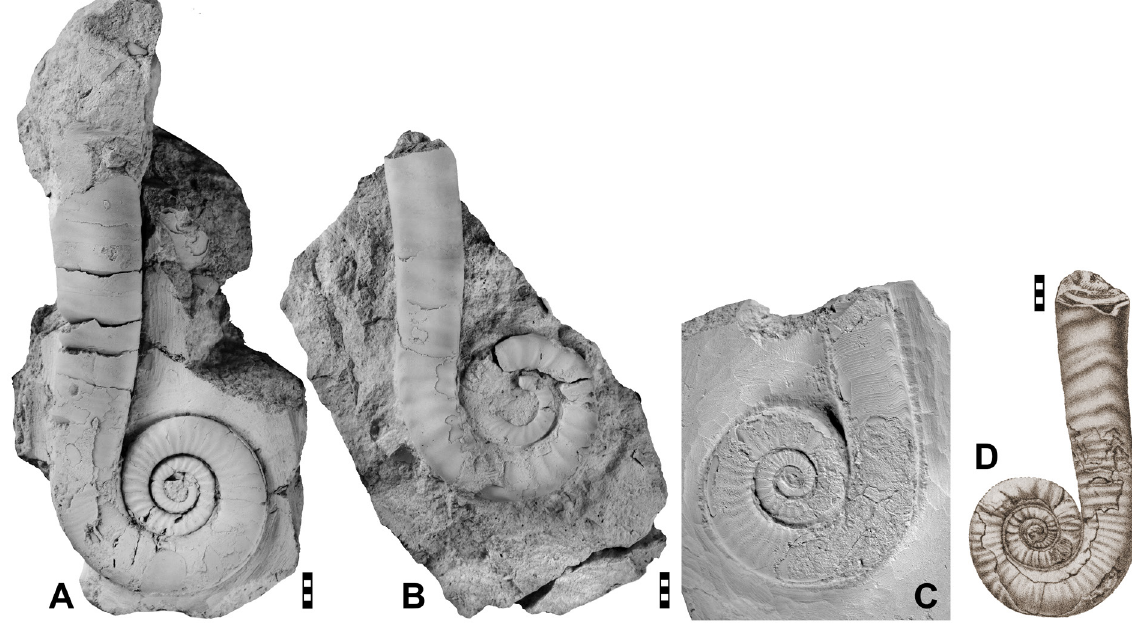
Fig. 47. Lituites procerus Remelé, 1890 from the Upper Grey Orthoceratite Limestone. A . Specimen MB.C.30547 (Krueger Coll.) from Oderberg (Brandenburg). B . Specimen MB.C.30546 (Neben & Krueger Coll.) from Hohensaaten (Brandenburg). C . Specimen MB.C.2498 from Niederfinow (Brandenburg). D . Reproduction of the illustration by Remelé (1890: pl. 6 fig. 1). Scale bar units = 1